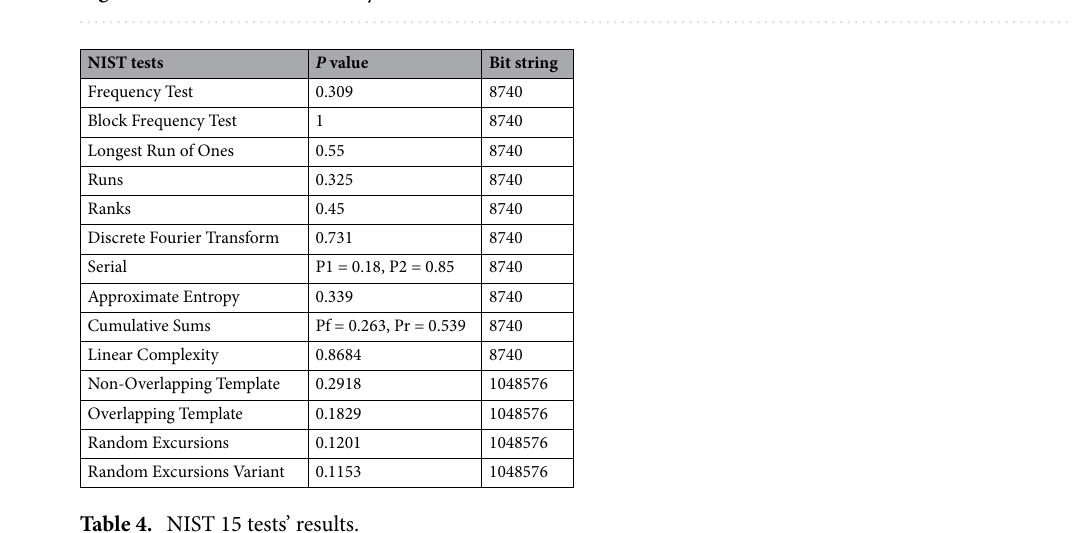
Figure 7. Endurance set-reset cycles of the fabricated MR-PUF.